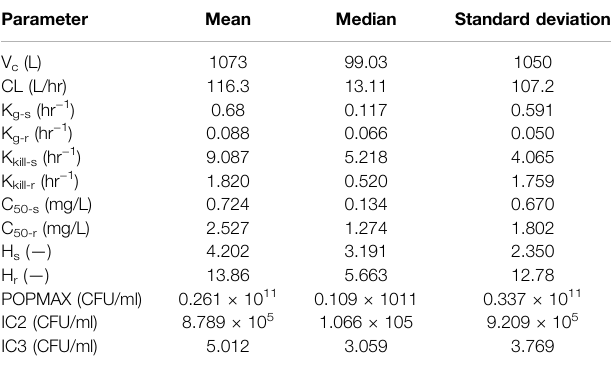
TABLE 2 | Mean, median and standard deviation of the parameter values for the Hollow Fiber Infection Model study with the N. gonorrhoeae clinical SE600/18 strain with a pre-existing GyrB S467N amino acid